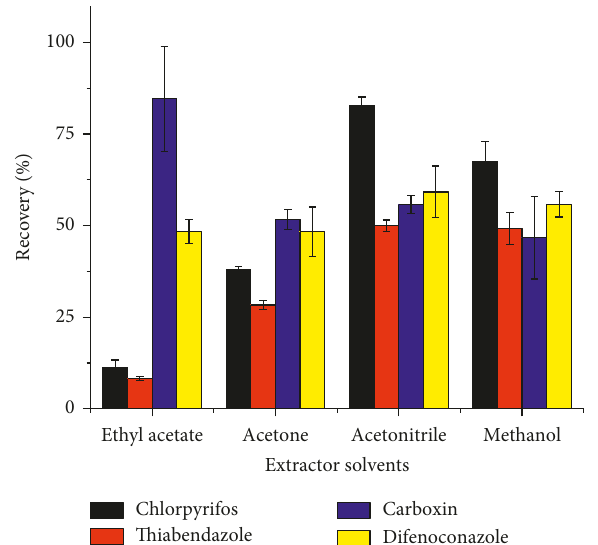
Figure 3: Pesticide residue recoveries in caj´a-manga by the SLE- LTP method using different volumes of